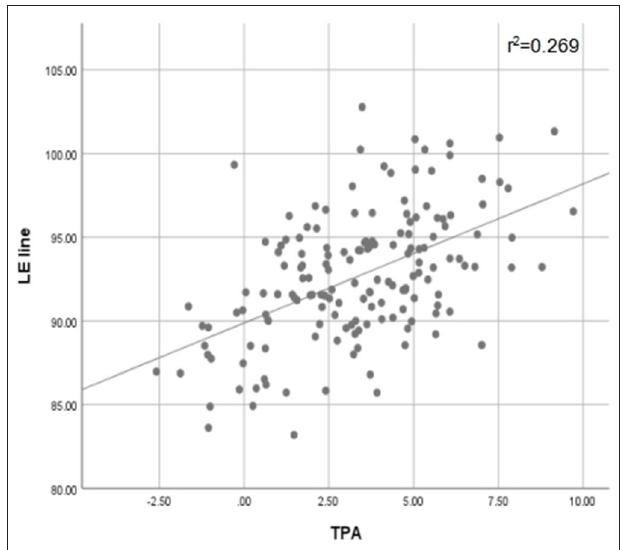
FIGURE 4 | Scatter Plots of LE line and TPA with Pearson’s correlation test. Correlation level (absolute value): low correlation ( < 0.3); moderate correlation ( ≥ 0.3 to < 0.5); high correlation (0.5 < to < 1). r 2 , coefficient of determination.